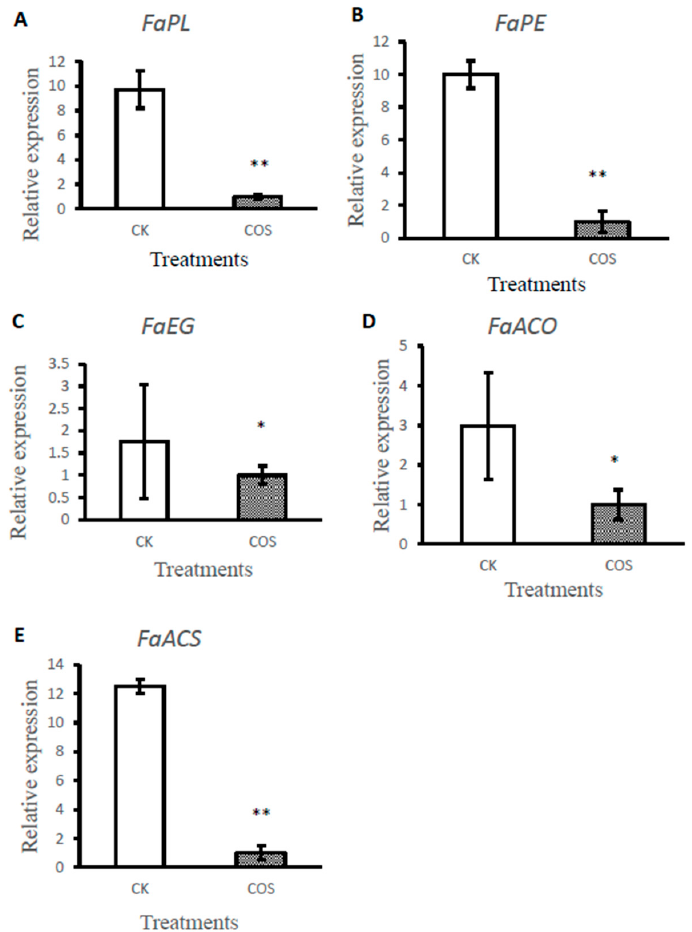
Figure 4. Effects of COS pre-harvest treatment on gene expression of some important enzymes involved in ethylene compound biosynthesis and cell wall degradation (( A ) PL: Pectin lyase; ( B ) PE: Pectin esterase; ( C ) EG: Endoglucanase; ( D ) ACS: ACC synthetase; ( E ) ACO: ACC oxidase). The error bars represent the standard deviation of three biological replicates. Stars indicate significant differences. Data represent the means ± SD. The * are significantly different according to T test at p ≤ 0.05 level. The ** are significantly different according to T test at p ≤ 0.001 level. CK: Spraying water pre-harvest; COS: Spraying COS pre-harvest.